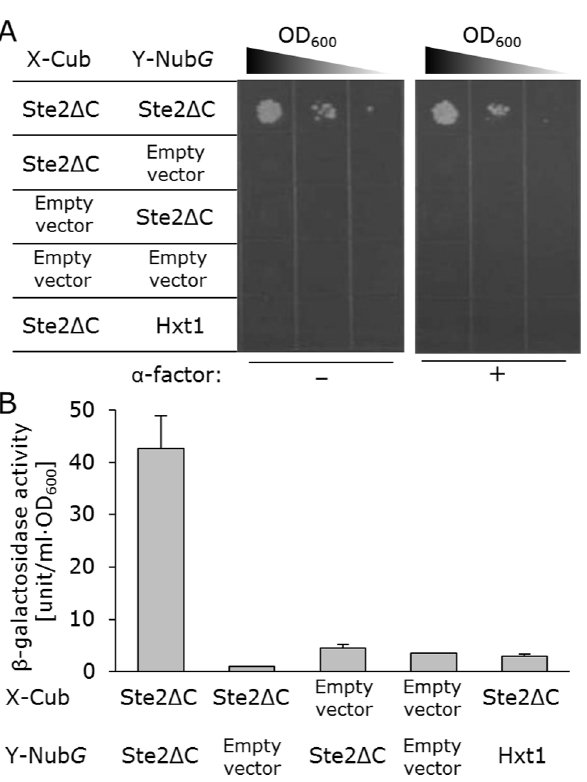
Figure 3. Detection for dimerization of yeast truncated Ste2p lacking the carboxy-terminal tail (Ste2 D C) receptor in NMY62 strain. Growth and quantitative b -galactosidase activity of yeast cells expressing various combinations of Cub and Nub G fusions. The control bait plasmid was pBT3-C mock vector (empty vector). The control prey plasmids were pPR3-C mock vector (empty vector) and pPR3-HXT1. (A) Growth assay without a -factor ( left panels ) and with 5 m M a -factor ( right panels ). Each cell was spotted in serial 10-fold dilutions on SD –Leu, Trp, Ade and His dropout plate. (B) Quantitative b -galactosidase assay. Error bars represent the standard deviations ( n=